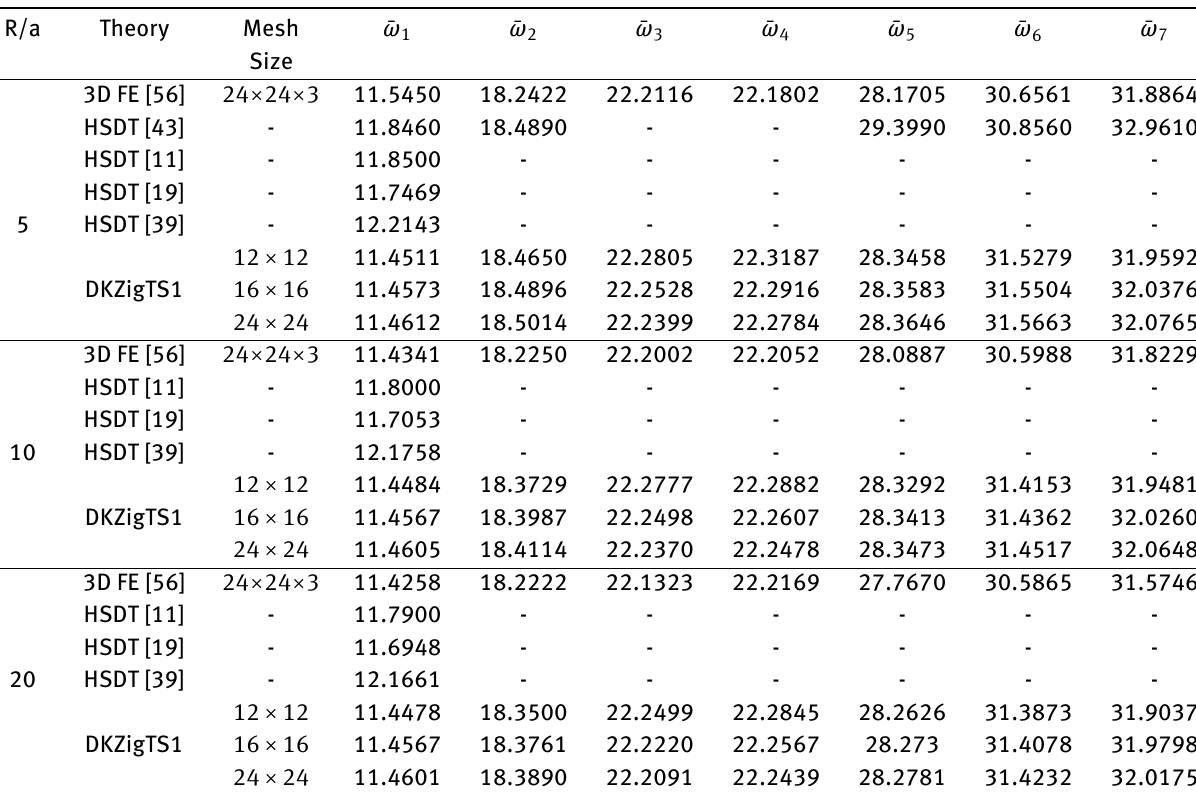
Table 2: Non-dimensionalised natural frequencies ¯ ω for an all-round simply supported composite cylindrical shell panel ‘A’ with b / a = 1 , h / a = 0.1